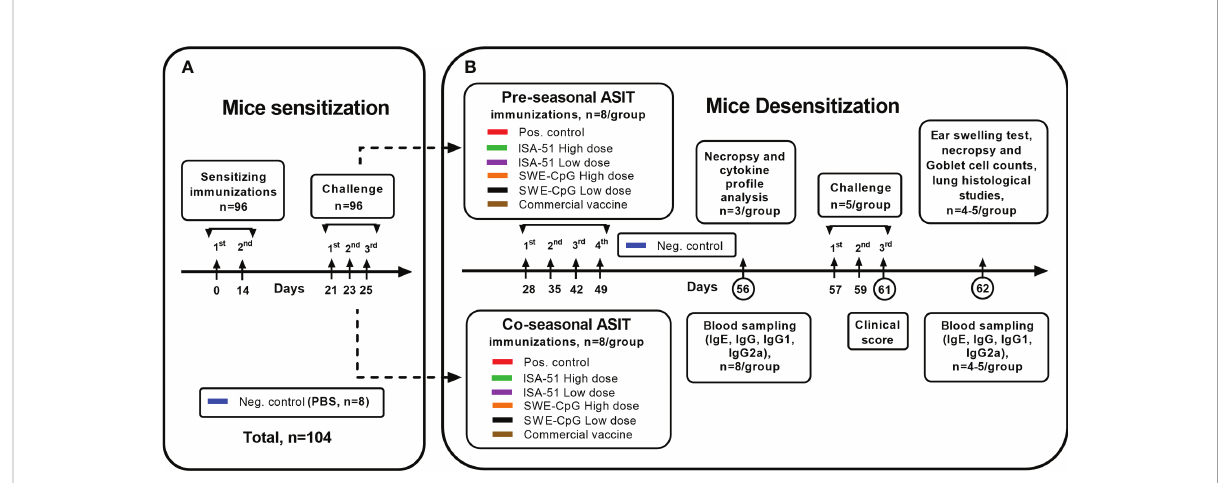
FIGURE 1 Study design. The schema of mice sensitization (A) by Artemisia vulgaris pollen extract and their desensitization (B) by vaccine formulations based on recombinant Art v 1 protein and various adjuvants using pre- and coseasonal ASIT regimens is